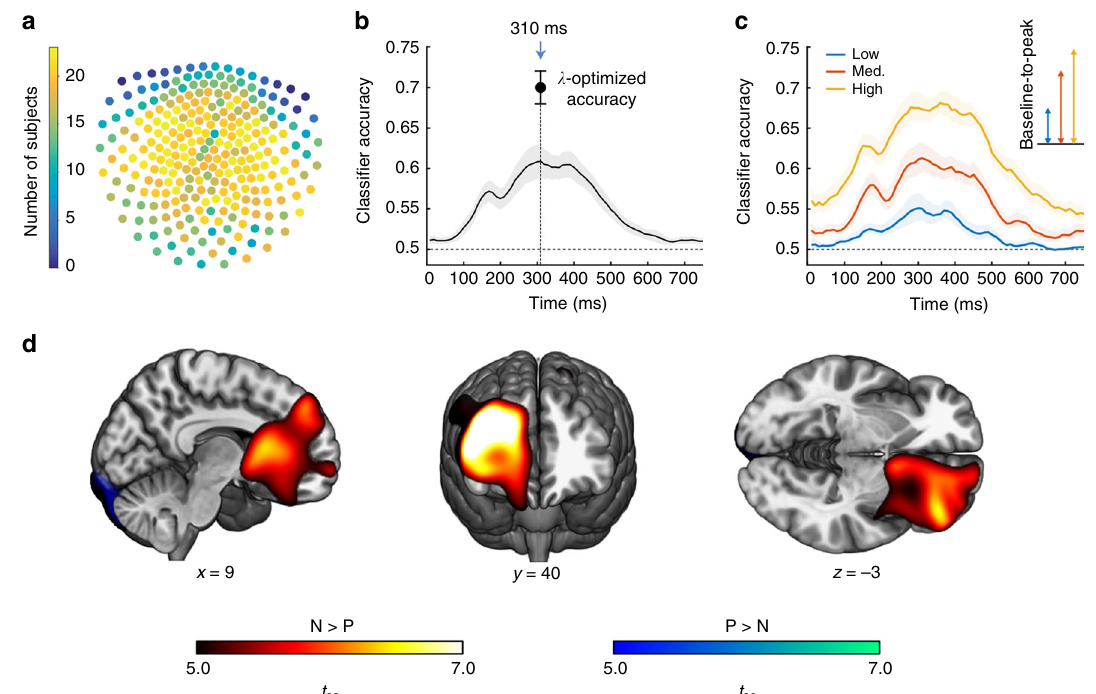
Fig. 2 Classi fi er construction. a Distribution of the participant-speci fi c set of 135 sensors that contained the fewest eye blinks. Warm-coloured sensors were retained more frequently. b Average balanced classi fi cation accuracy (thick black line) with its standard error of the mean (grey shade), obtained from n = 21 participants, as a function of time elapsed after outcome onset ( t = 0). For selection of the post-outcome time bin, the Lasso coef fi cient λ was set arbitrarily to 0.025. At the resulting peak time bin (310 ms), λ was then optimised to build the classi fi er used for decoding, resulting in an average balanced accuracy of 0.70 ± 0.02 (mean ± s.e.m.; black dot). c Same as in b , but after dividing the training set according to loss probability. Classi fi cation accuracy is particularly low when negative outcomes are rare (low). Inset: comparison of the baseline-to-peak accuracy at 310 ms for each threat probability. d Source reconstruction of brain activity around the time bin used for building the classi fi er (310 ms), computed with a beamforming algorithm on an interval of 100 ms duration. Figure shows brain regions where broadband oscillatory power (1 – 50 Hz) was higher for the negative outcome (N, warm colours) or for the positive outcome (P, cold colours). Results are corrected for whole-brain family-wise error (FWE) at p < 0.05. Copyright (C) 1993 – 2004